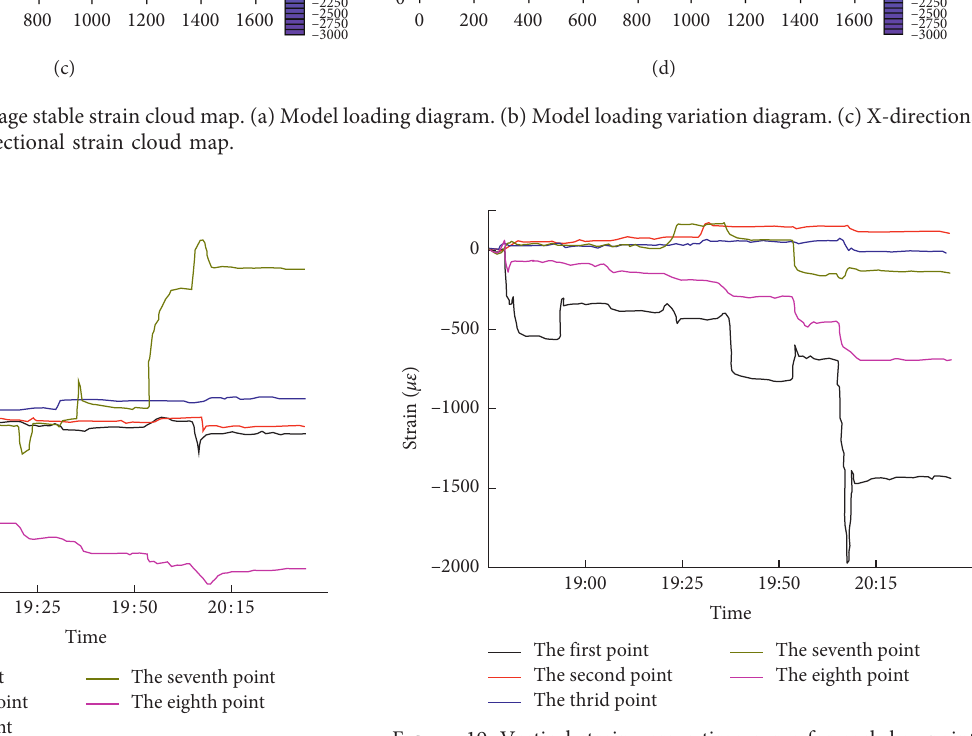
Figure 18: Curve of horizontal strain versus time at each key point.